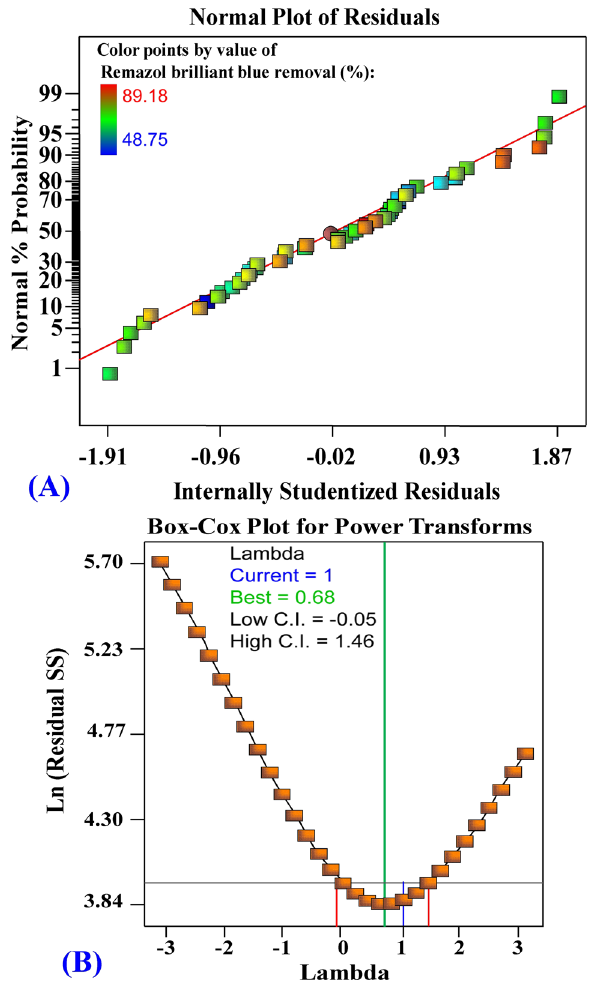
Figure 4. ( A ) Normal probability plot of internally studentized residuals, and ( B ) Box–Cox plot of model transformation of biosorption of Remazol brilliant blue dye by Gelidium corneum